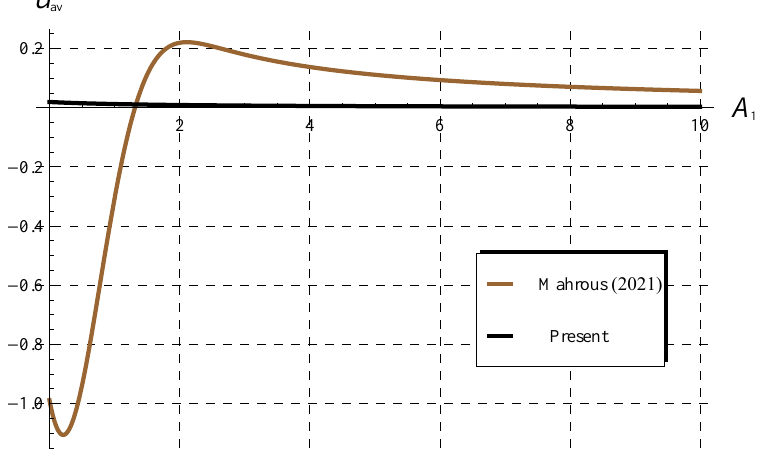
Figure 12. Comparisons between the present cup-mixing average concentration u av and the corre- sponding ones in Mahrous [7] at α = 1 (fractional chlorine decay), A 0 = 1.4, and A 2 = 2